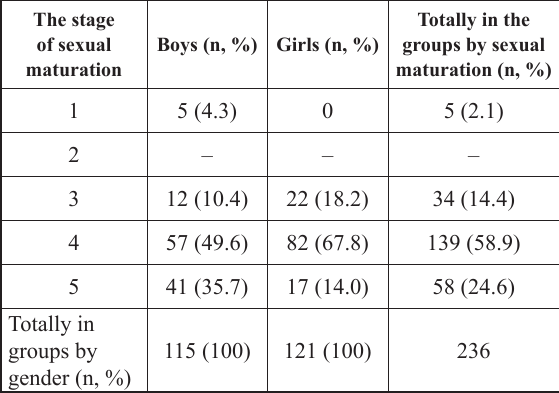
Table 1. Expression of sexual maturation in boys and girls in the sample (χ² = 22.23; df = 3; p < 0.001) The stage of sexual